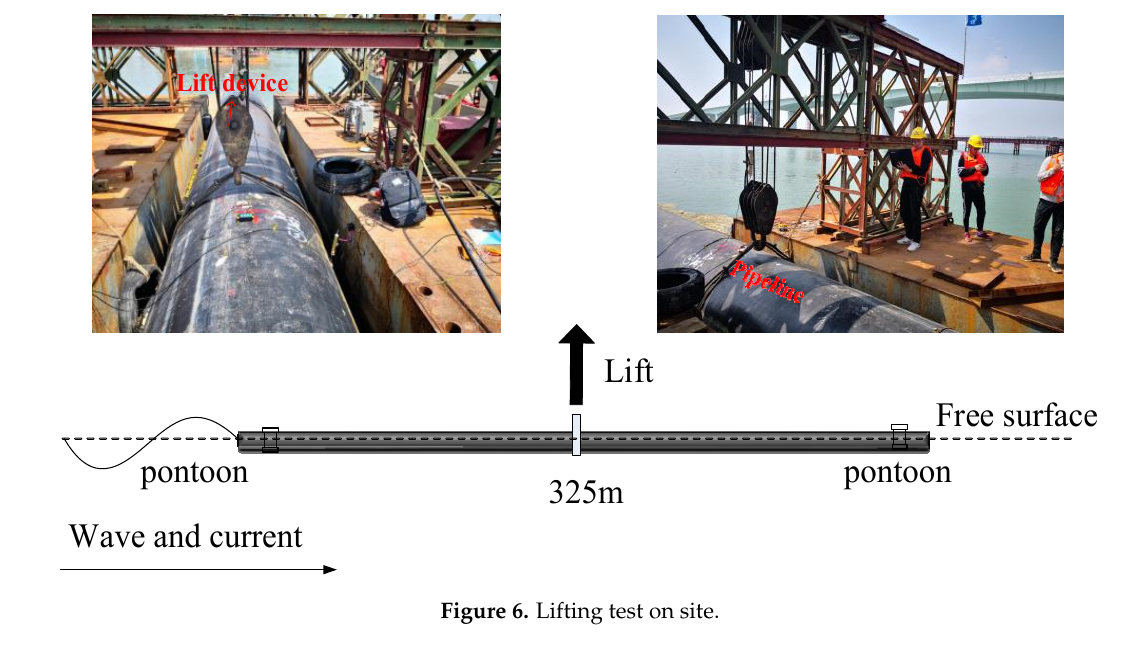
Figure 5. Flow chart of field monitoring data transmission.